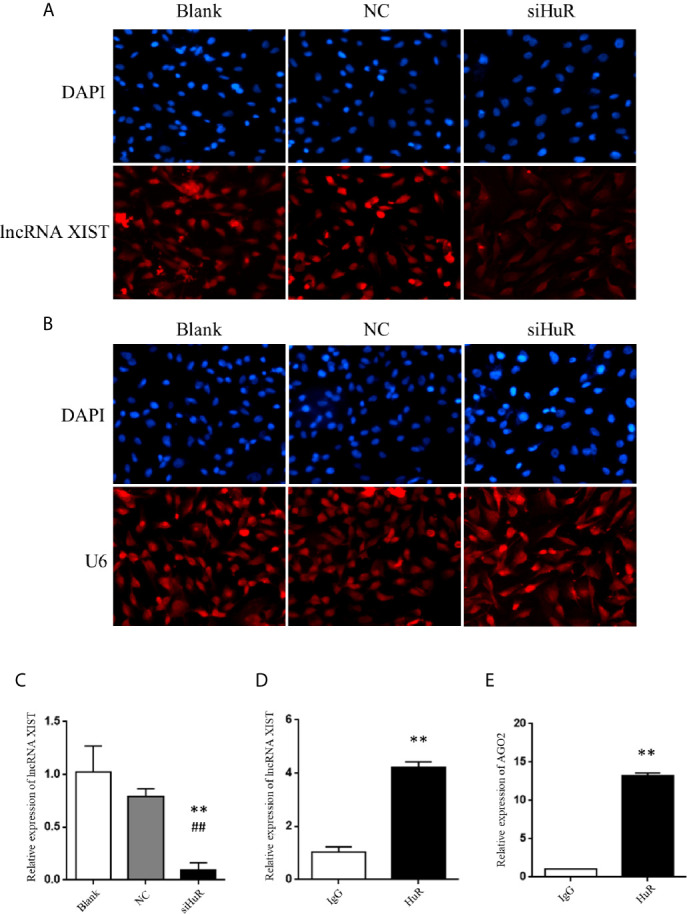
Silencing of HuR represses lncRNA XIST expression in OS cells. (A) RNA fluorescence in situ hybridization (FISH) analysis of lncRNA XIST with a specific probe in SASJ-1 OS cells. (B) U6, a ribonucleoprotein, served as the endogenous control for FISH analysis; the nucleus was stained with DAPI. (C) The mRNA level of lncRNA XIST was detected by qPCR in cells after different treatments. ** indicates P < 0.01 compared to the blank group. ## indicates P < 0.01 compared to the NC group. qPCR was used to measure the lncRNA XIST (D) and AGO2 (E) abundance in the HuR-IP complex following the RIP assay. ** indicates P < 0.01 compared to the mouse IgG group.